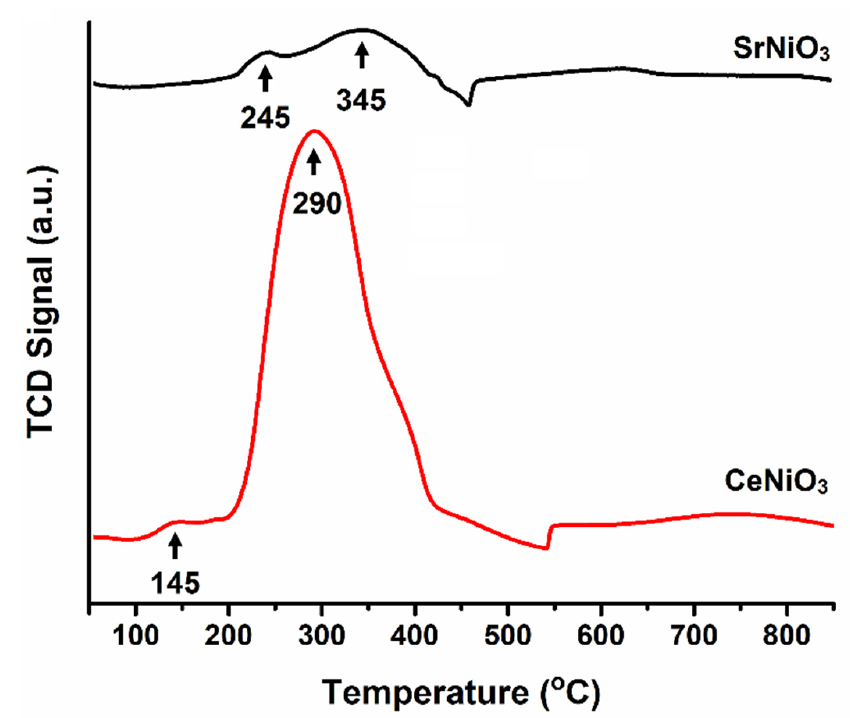
Table 2. Textural properties and deactivation factors of SrNiO 3 and CeNiO 3 perovskites. Figure 4. H 2 -TPR profiles of SrNiO 3 and CeNiO 3 perovskites. Figure 4. H 2 -TPR profiles of SrNiO 3 and CeNiO 3